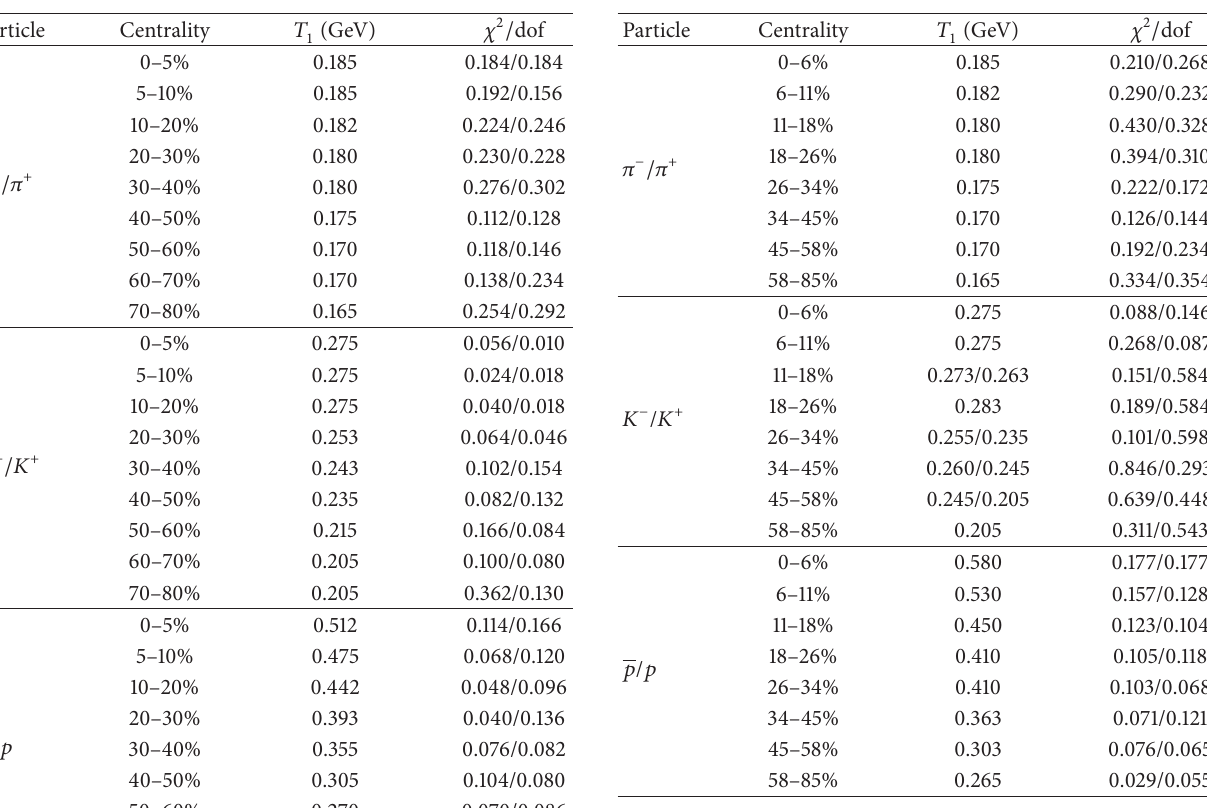
Figure 4(e)/Figure 4(f)